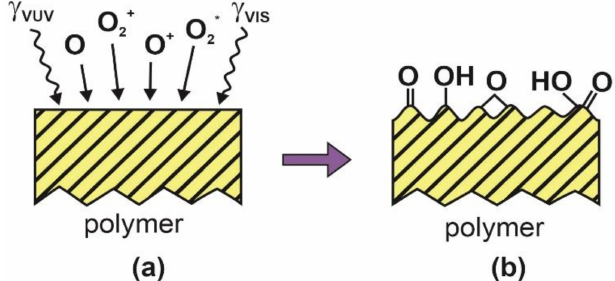
Figure 1. ( a ) Originally smooth polymer. ( b ) Polymer after exposed to oxygen plasma assumes rich morphology and becomes functionalized with polar surface